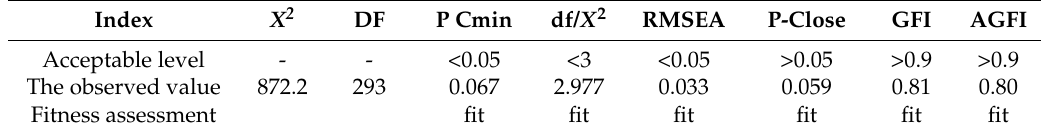
Table 7. Fitness indexes of the final model of the behavior of using PISs of